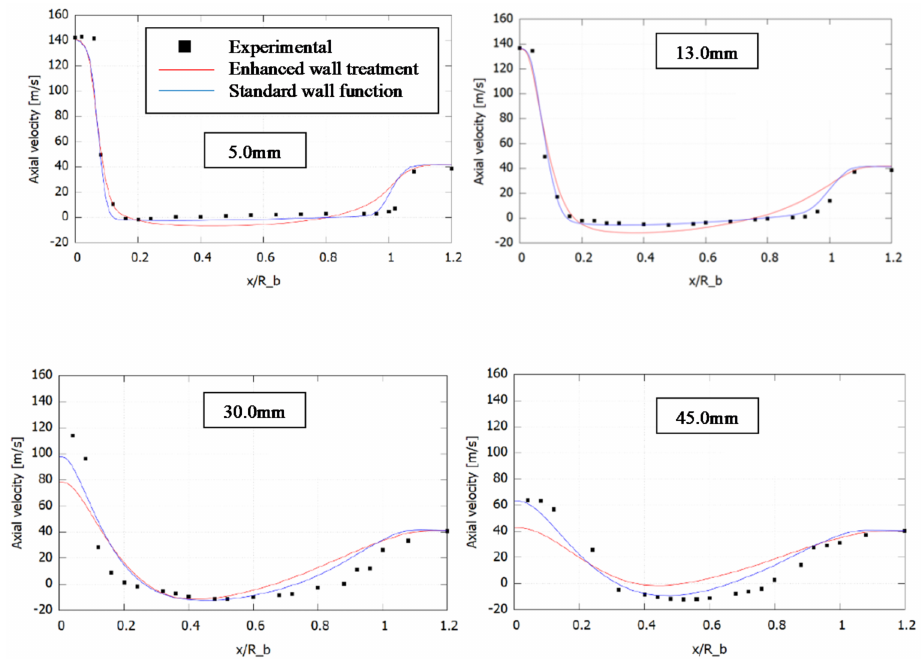
Figure 6. Axial velocity profiles at increasing axial distances. SAGE/GRI-Mech 3.0. Complete experimental data available at reference